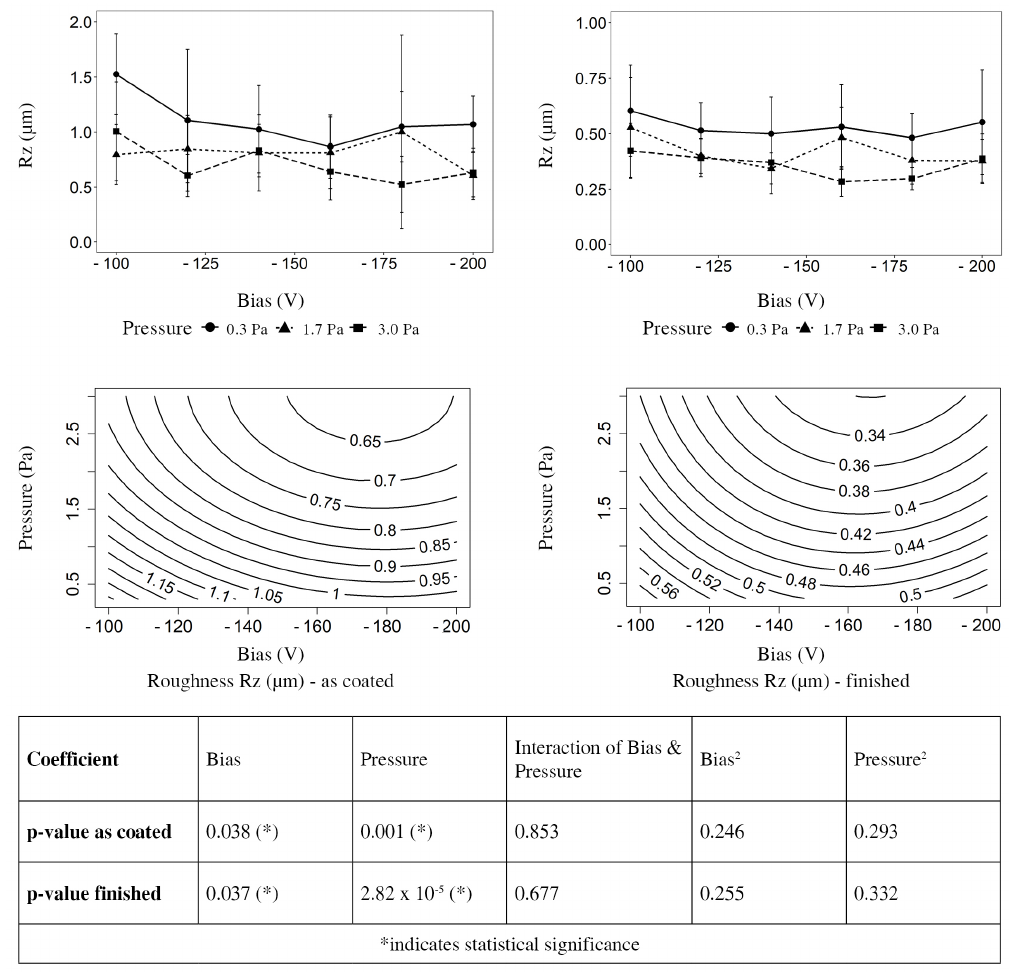
Figure 3. Scatter plots and response surface of the line roughness Rz as coated and finished. The effect of the finishing process is significant, with respect to the peak height of the roughness profile (R p ). The maximum R p of unfinished samples is 0.8 µm (Figure 4) while the maximum R p of finished samples is below 0.25 µm. The maximum valley depth is also significantly reduced. All samples show R v below 0.5 µm after the finishing process (Figure 5). Furthermore, the process pressure shows a significant impact ( p = 0.006) on R p , re- sulting in a reduction in the peak height when increasing the nitrogen pressure. The process pressure exhibits the same effect on the maximum valley depth (R v ) with p < 0.001 for as coated and finished samples, respectively. The negative substrate bias ( p = 0.006) and the quadratic proportion ( p = 0.042) of the bias exhibit a significant impact on the maximum peak height (R p ), resulting in a lo- cal minimum at − 160 to − 180 V.